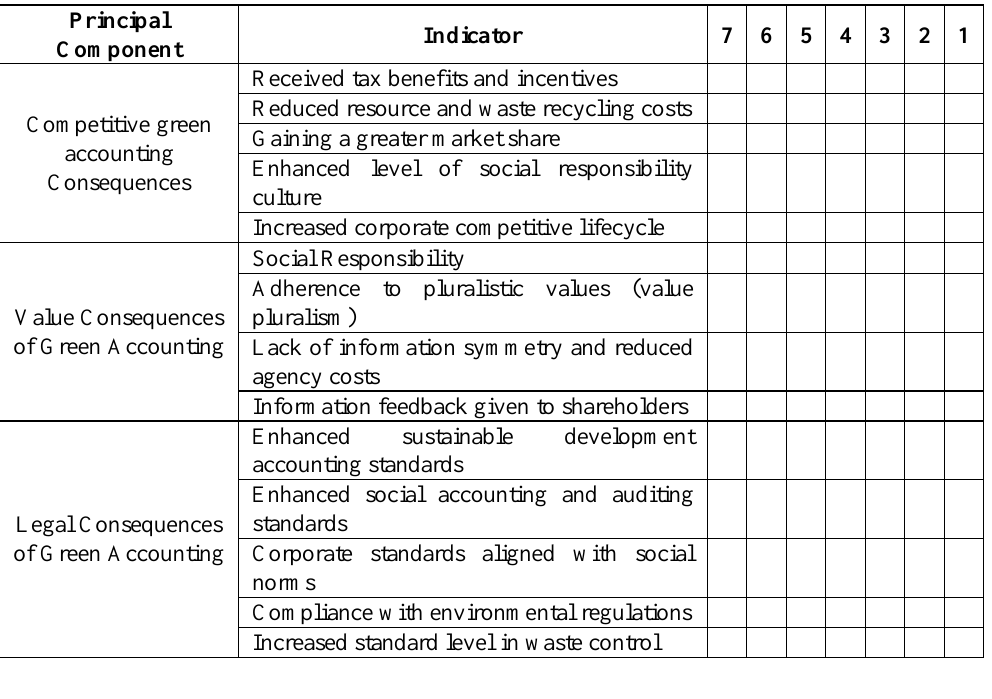
Table 6. Components and indicators of strategic Consequences of green